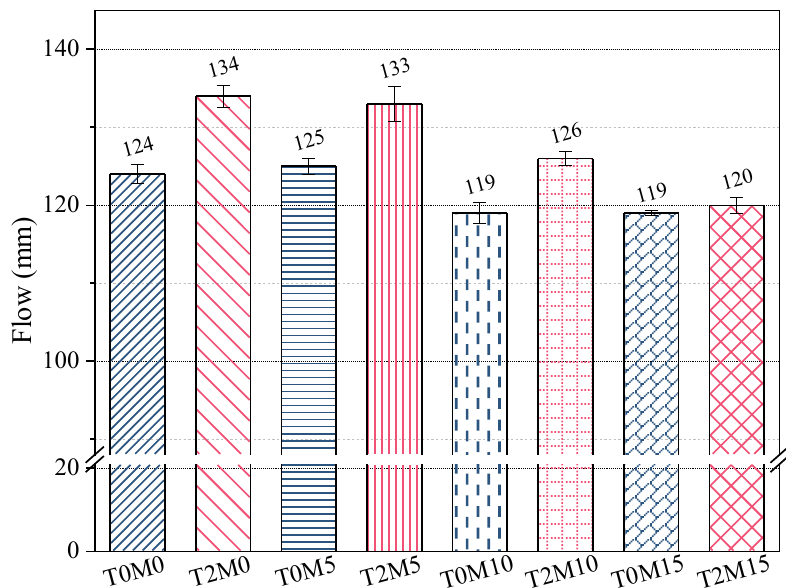
Figure 2. Flowability of MK blended mortars mixed with black tea extract.